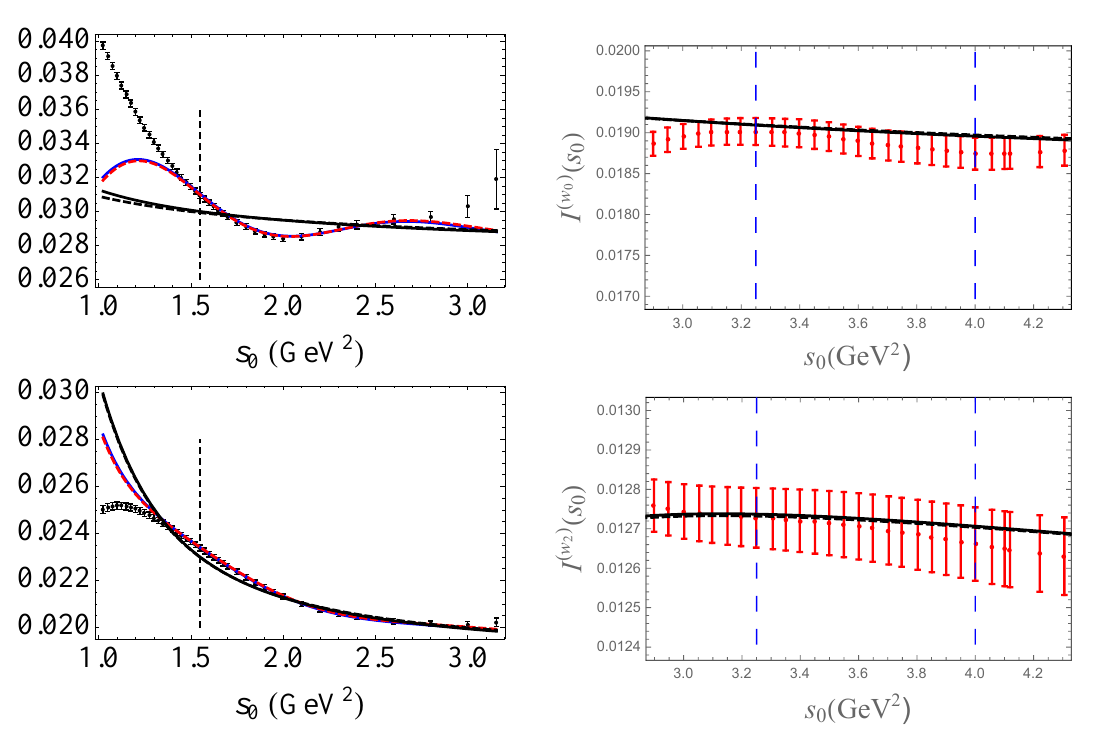
Figure 5: Comparison of FESR fits extracting α from hadronic τ data (left panels) s vs. e + e − → hadrons ( γ ) (right panels). Top panels show fits with weight w , bottom 0 panels show fits with weight w . Because of the comparison between τ -based mo- 2 ments and e + e − -based moments, we show those obtained from the vector channel in the plots on the left. For more detail, see main